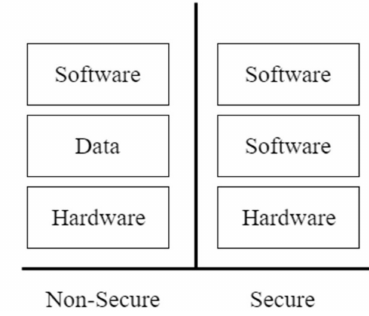
Figure 6. Non-secure and Secure